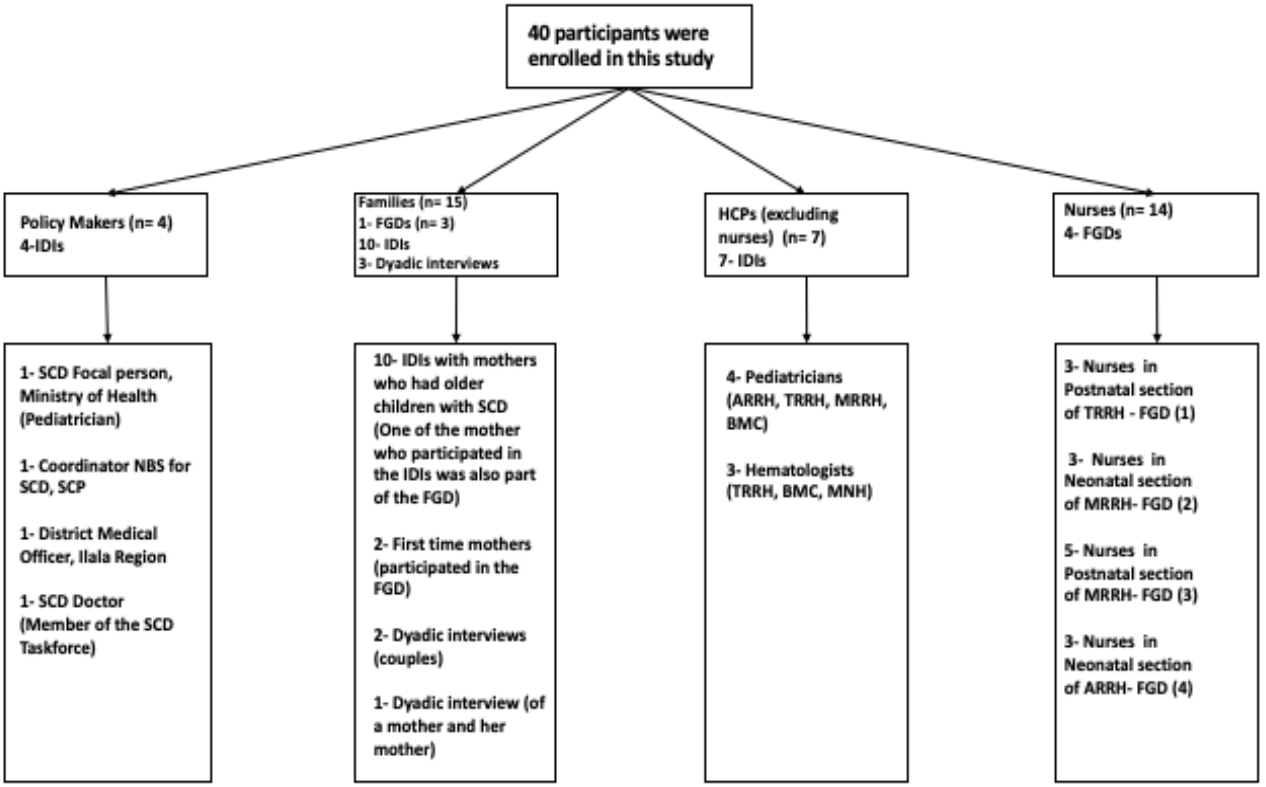
Figure 2. Summary of the description of participants included in this study and methods used for data collection (in-depth interviews (IDIs) and/or focus group discussions (FGDs)). HCP—Health Care Professionals; NBS—Newborn Screening; SCD—Sickle Cell Disease; SCP—Sickle Cell